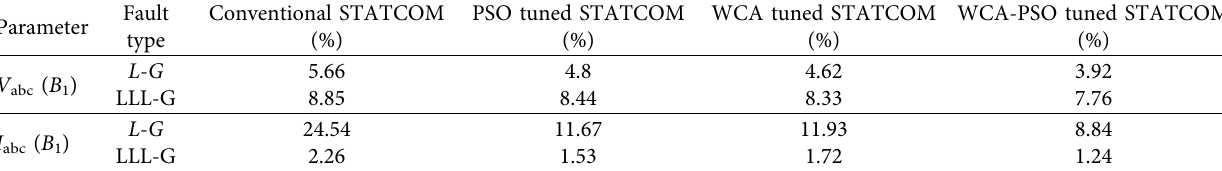
Table 12: THD as a % of the fundamental value.